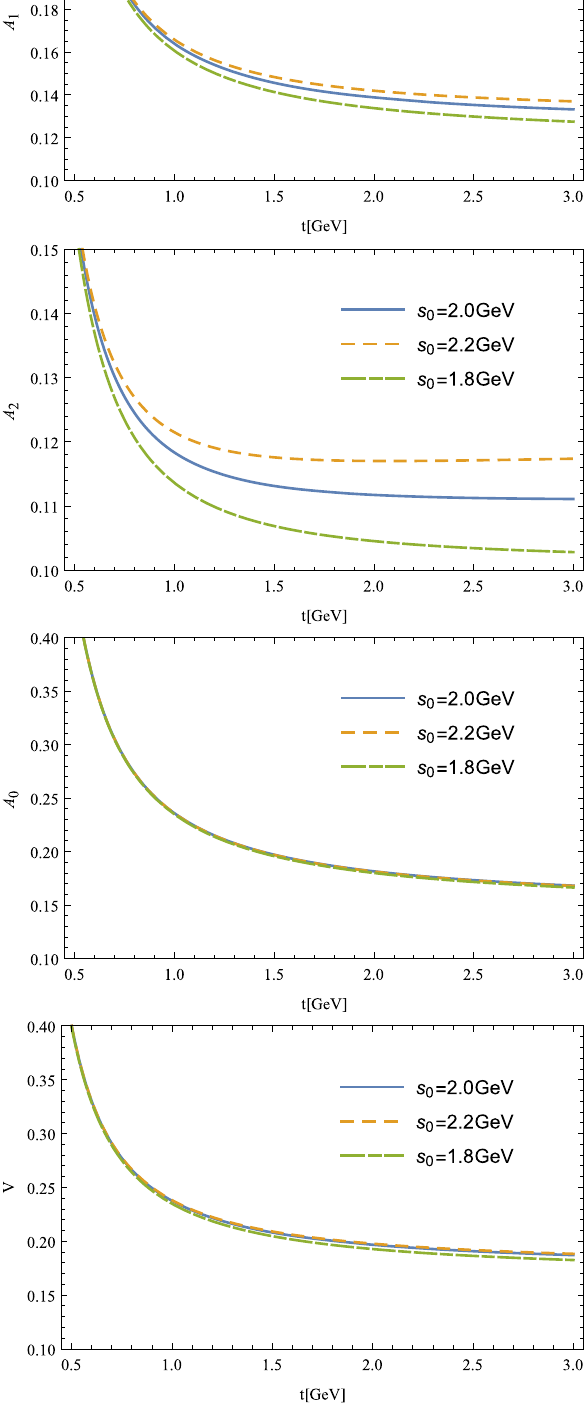
Fig. 1 B → a 2 ( 1320 ) form factors as functions of t for different s 0 at q 2 = 0